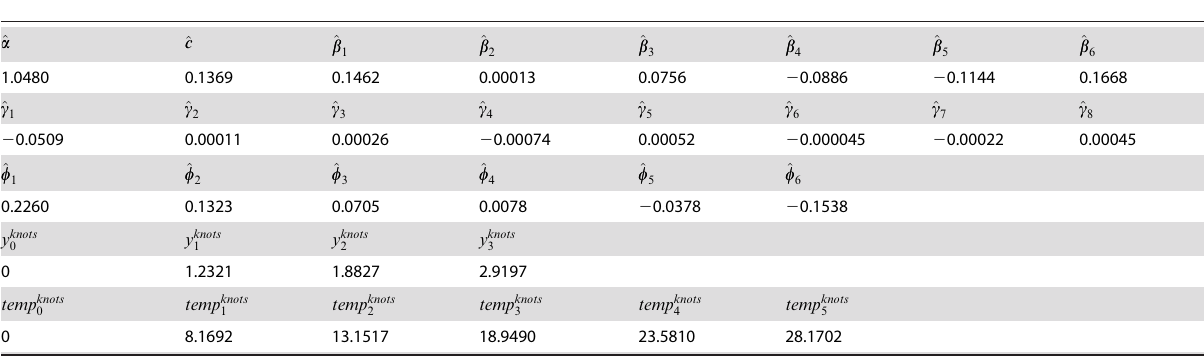
Table 3. Parameter estimation of predictive